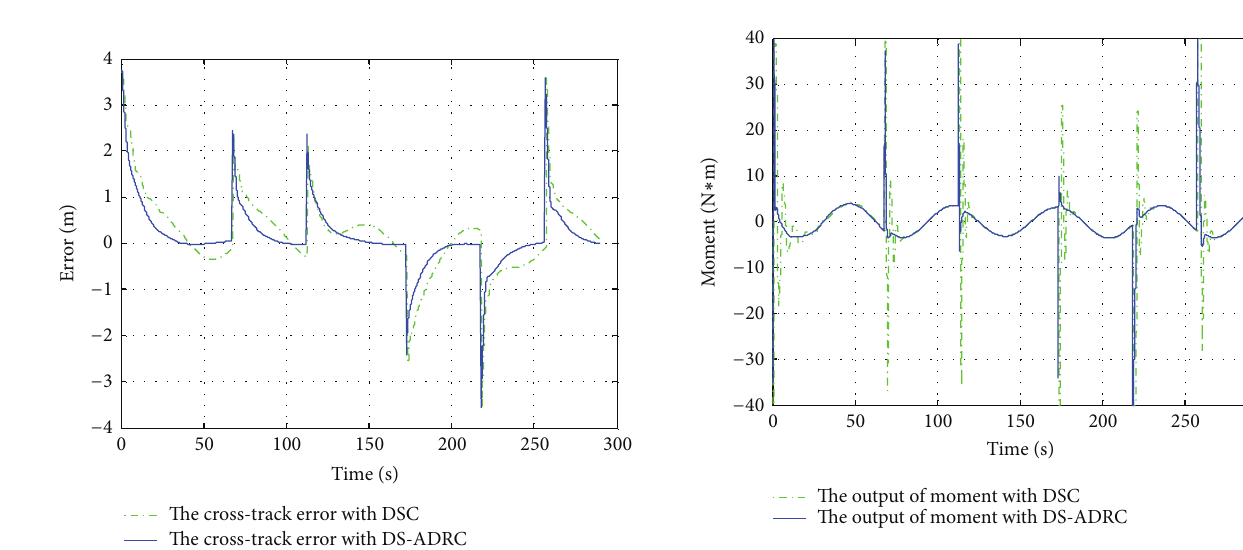
Figure 8: The responses of path following.